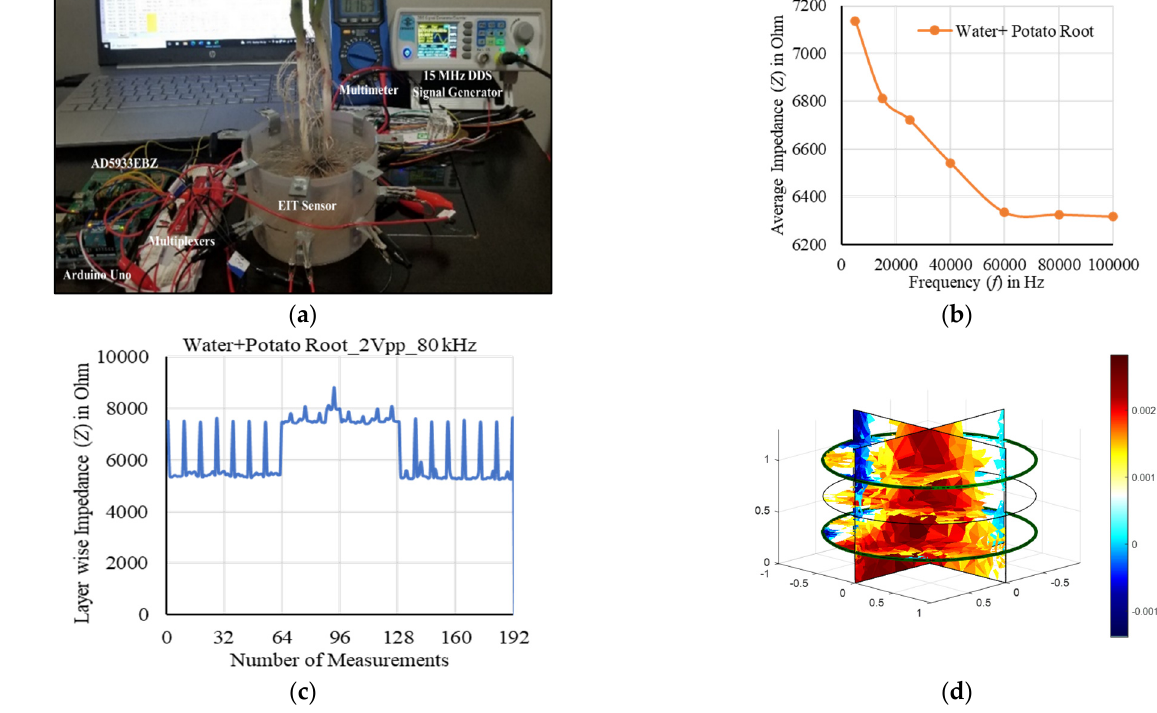
Figure 19. ( a ) An EIT experimental setup for the measurements of a potato root system, ( b ) average measured impedances for 5–100 kHz of an inhomogeneous media (water + root), ( c ) layer-wise measured impedances at 80 kHz, and ( d ) reconstructed potato root (tap root) using 3D EIT measurements in water at 80 kHz, 2 Vpp, and 1 mA stimulation current considering GN: NOSER ( λ = 2.17). The obtained result shows a conductive behaviour of the root with maximum changes of conductivity of 0.003.